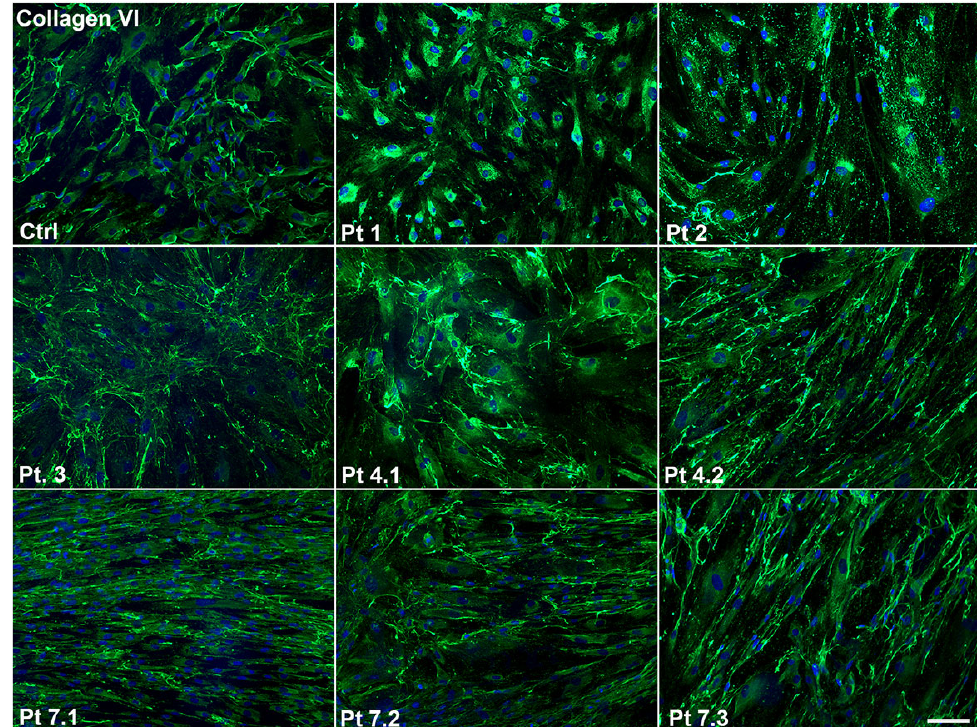
Figure 3. Immunofluorescent staining of Collagen VI on COL6-RM skin-derived fibroblasts. The staining shows variability in fluorescent signal distribution ranging from a complete collagen cellular retention (Pts 1 and 4.1) to altered extracellular deposition (Pt 2) and a variable collagen fibril arrangement (Pts 3 and 7.1). Nuclei were counterstained with DAPI. Ctrl: fibroblasts from normal skin biopsy. Scale bar: 50 μ m.